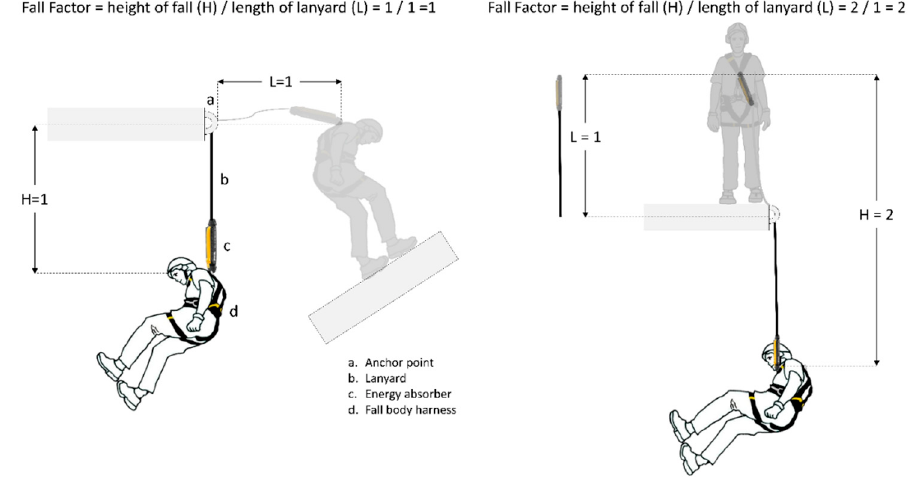
Figure 1. Fall factor (FF) studied. FF = 1 ( left ) and FF = 2 ( right ).